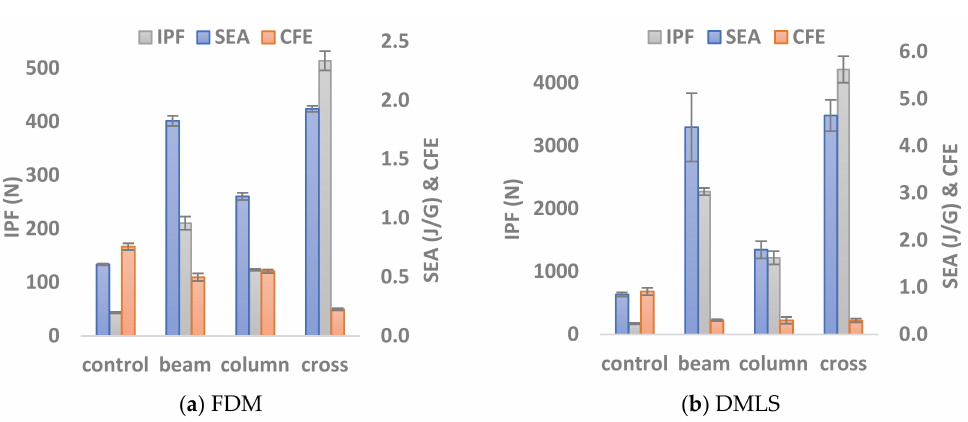
Figure 7. Bar charts summarizing the performance levels in terms of IPF, SEA, CFE exhibited by the